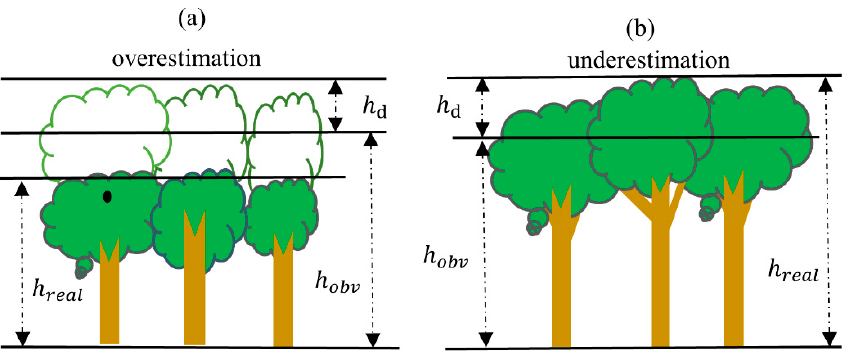
Figure 6. Schematic illustration of underestimation and overestimation of forest canopy height.